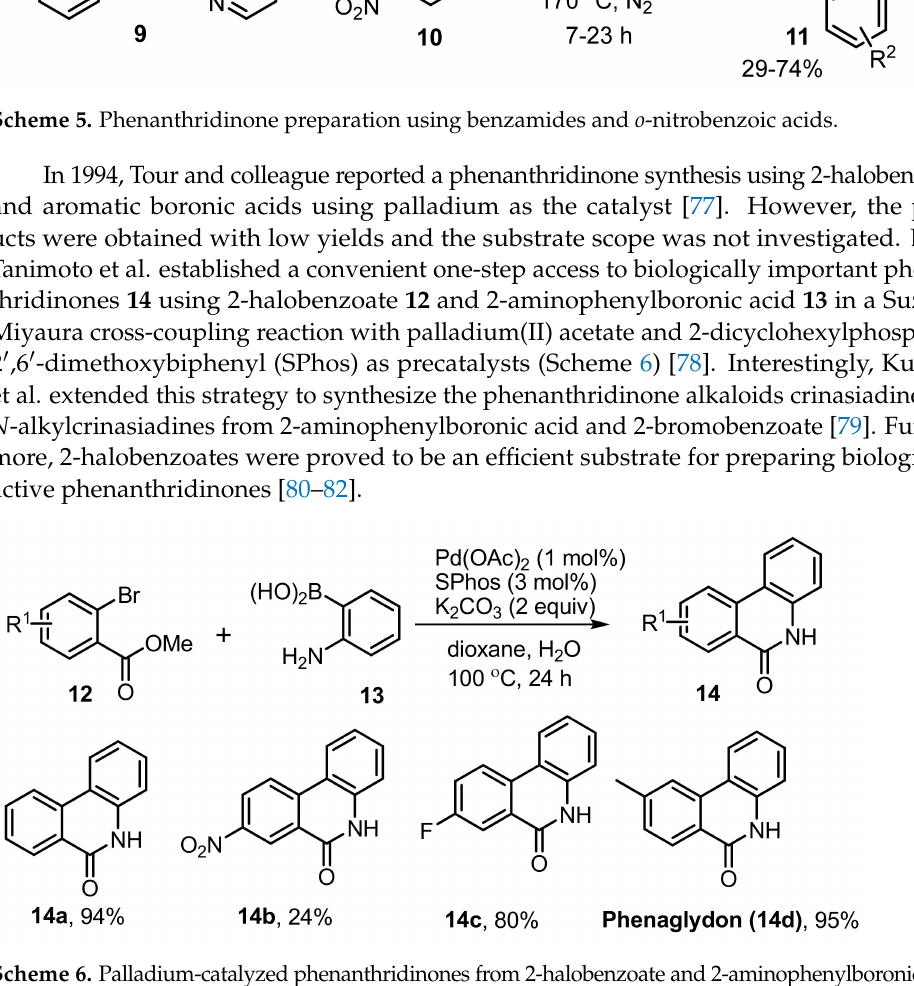
Recently, Ding et al. reported the synthesis of phenanthridinones 17 through Pd- catalyzed cyclization of N -aryl-2-aminopyridine 15 with 2-iodobenzoic acid 16 via C(sp 2